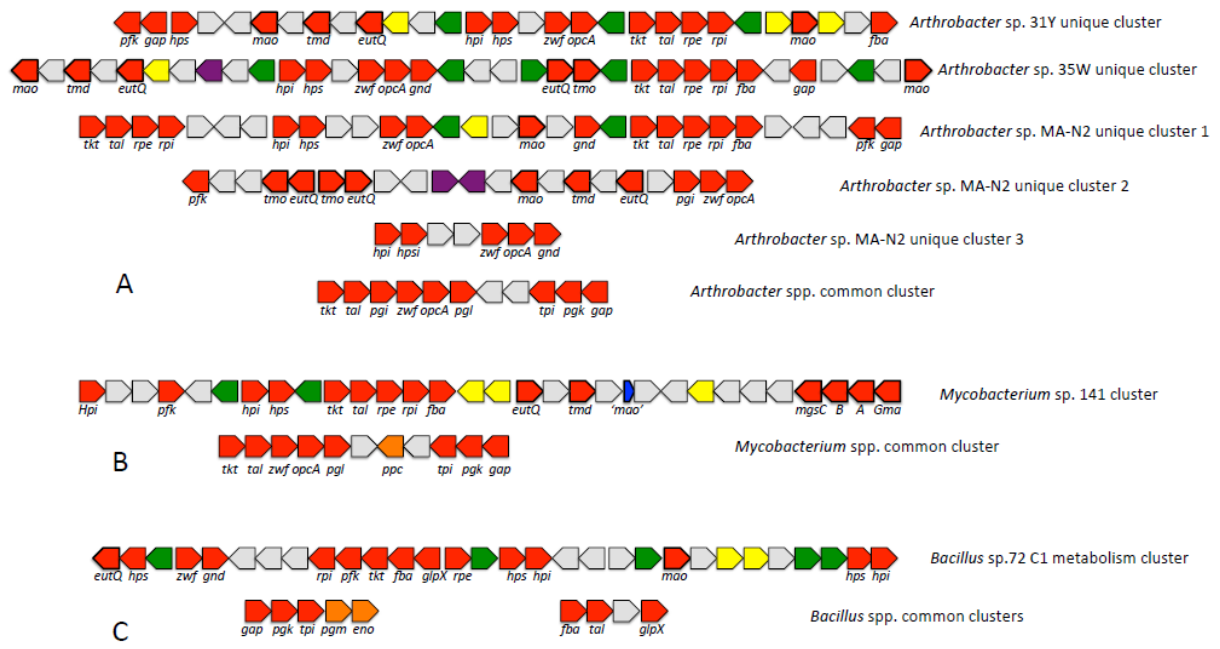
Figure 2. Methylotrophy gene clusters identified in the genomes described. Clusters identified in Mycobacterium sp. 155 and Bacillus sp. 37A are syntenic to the clusters shown for Mycobacterium sp. 141 and Bacillus sp. 72, respectively. In red, genes for methylotrophy functions. Genes for primary oxidation have bold lines. In green, genes encoding regulatory functions. In yellow, genes encoding transport functions. In grey, hypothetical genes or non-methylotrophy genes. In purple, genes encoding transposases. In orange, genes not essential for methylotrophy, but involved in other pathways sharing reactions with the RuMP cycle. In blue, the truncated Mao gene in the Mycobacterium methylotrophy clusters. Gene designations as indicated in the text. Common clusters ( i.e ., present in all strains of this genus) are identifiable not only in the strains described here, but also in multiple genomes of, respectively, Arthrobacter , Mycobacterium and Bacillus species. These are likely not methylotrophy specific. Genes in the unique clusters ( i.e ., unique to each strain) of Arthrobacter are typically highly related to the genes in the unique clusters of Mycobacterium (AI > 80%), suggesting lateral transfers; genes in the common clusters are less related (AI 50%–60%, in agreement with AAI), suggesting vertical